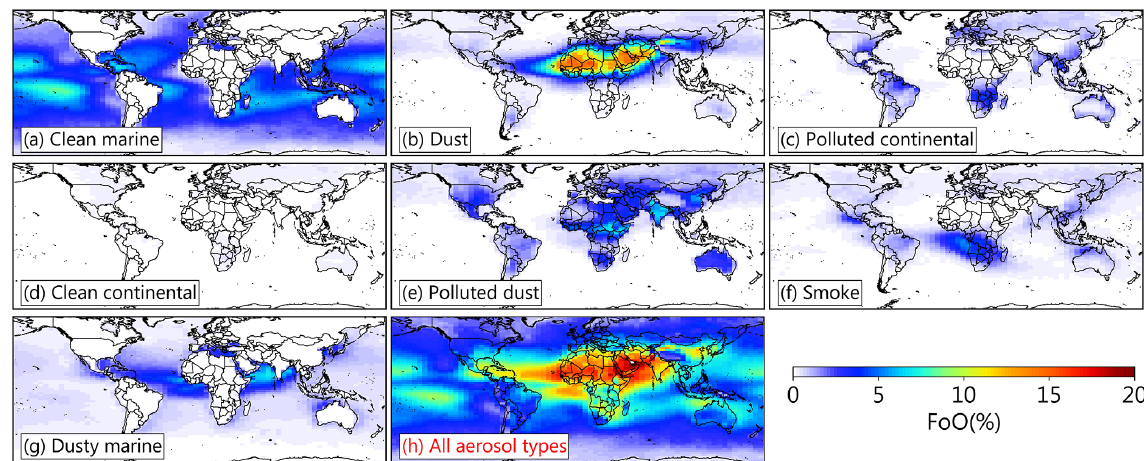
Figure 9. Spatial distribution of the multi-year average total columnar FoO for (a–g) CALIOP-classified aerosol subtypes and (h) the sum of all aerosol subtypes.